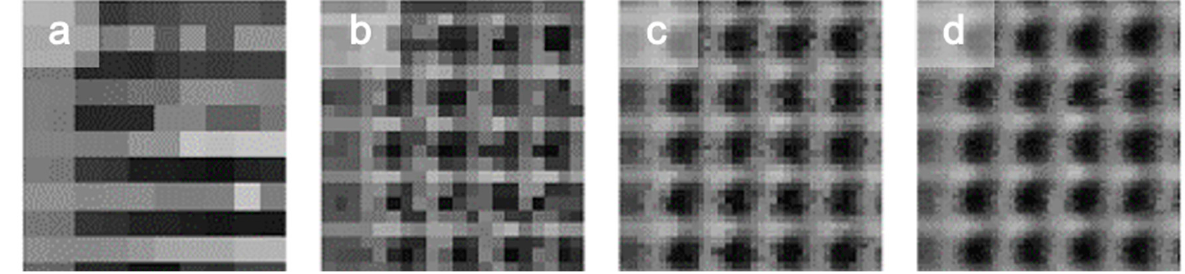
Figure 3. STOM images of an 800 nm-wide squared pattern using a diffracted spot of 750 nm with an objective of x60, with steps of ( a ) 750, ( b ) 400, ( c ) 200, and ( d ) 100 nm.